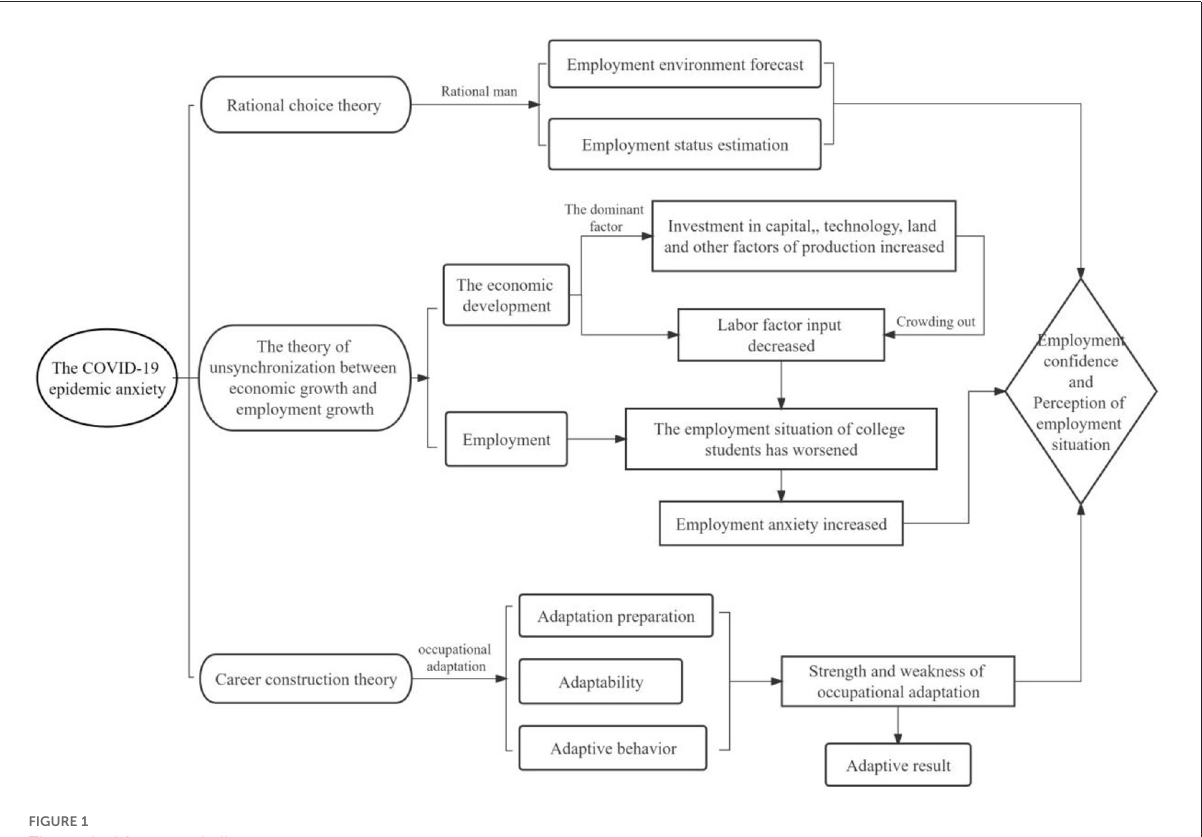
FIGURE1 Theoretical framework diagram.